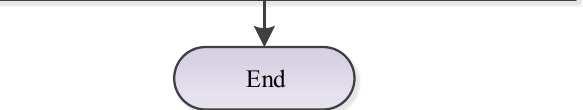
Figure 3. The evidential Induced Ordered Weighted Averaging (IOWA)-based fault diagnosis